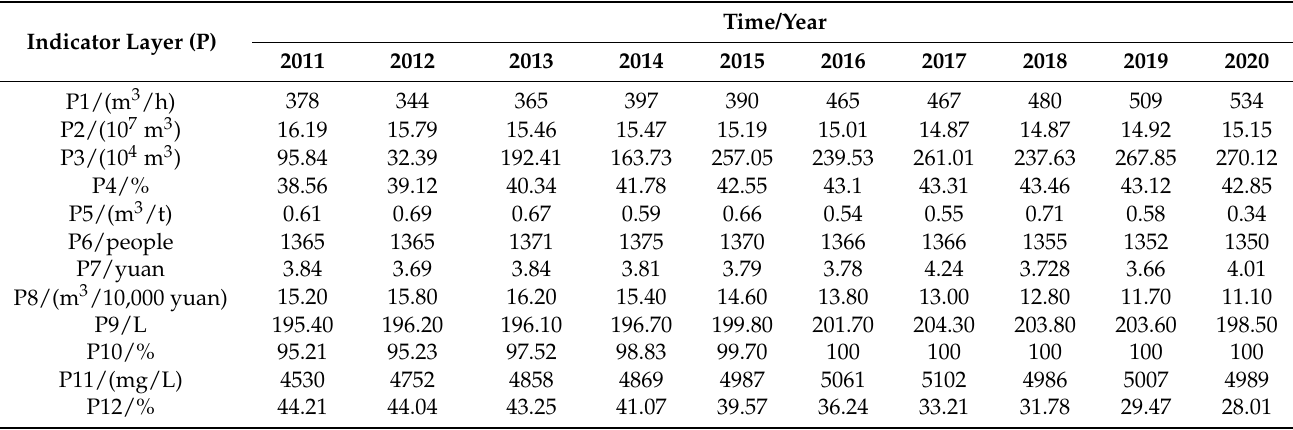
Table 2. Field data of indicators P1–P12.